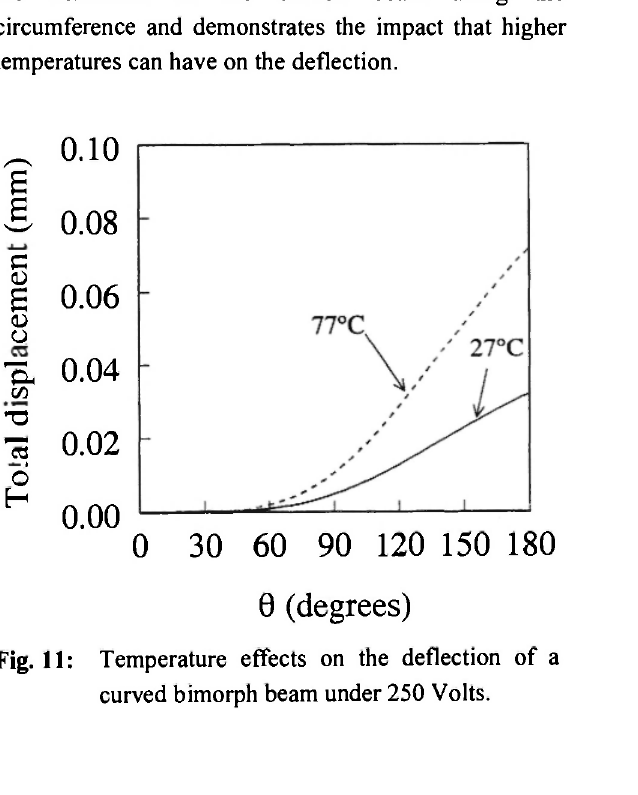
Fig. 11: Temperature effects on the deflection of a curved bimorph beam under 250